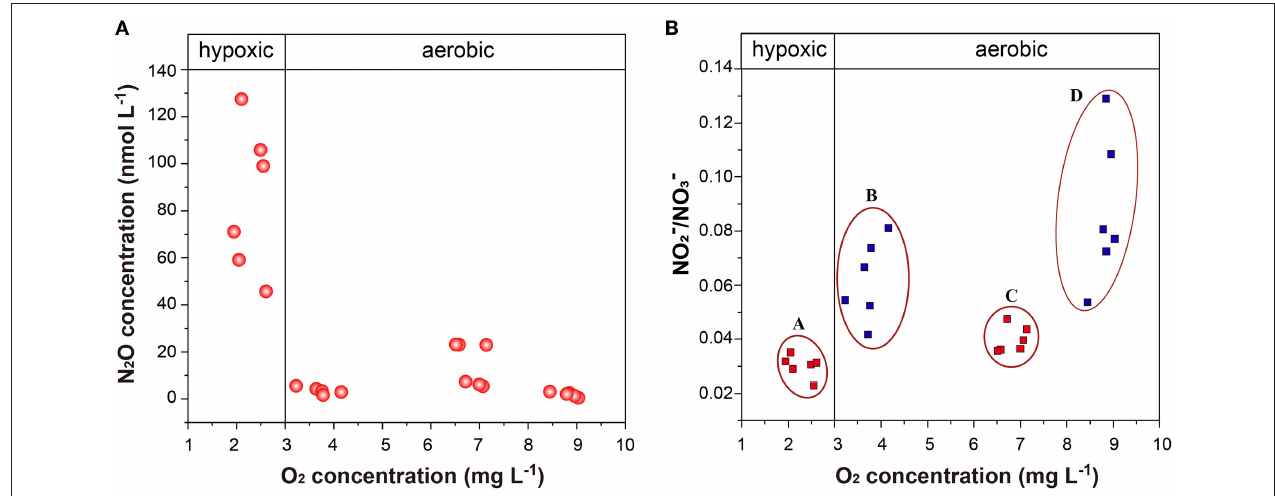
FIGURE 9 | (A,B) O 2 concentration vs. N 2 O concentration and NO − 2 /NO − 3 after incubation for (A) high anthropogenic nitrogen input seawater under Hyp; (B) low anthropogenic nitrogen input seawater under Hyp; (C) high anthropogenic nitrogen input seawater under Con; and (D) low anthropogenic nitrogen input seawater under Con. Con, control; Hyp, hypoxia; Acid, acidification; Aci + Hyp, the combination of hypoxia and